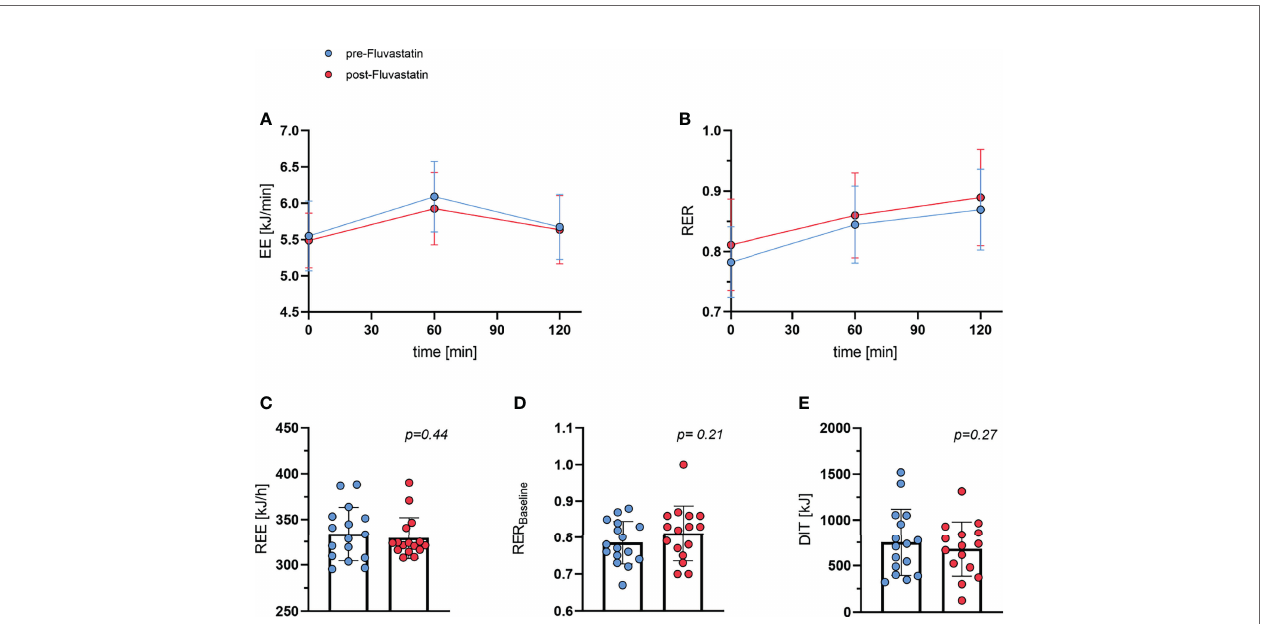
FIGURE 4 | Whole body energy expenditure and respiratory exchange ratio. (A) Energy expenditure (EE) during oGTT. Effect of time after ingestion of glucose p < 0.0001, effect of fl uvastatin p = 0.57, interaction between time x fl uvastatin p = 0.21. (B) Respiratory exchange ratio (RER) during oGTT. Effect of time after ingestion of glucose p < 0.0001, effect of fl uvastatin p = 0.28, interaction between time x fl uvastatin p = 0.56. (C) Resting energy expenditure (REE) before and after two weeks of fl uvastatin p = 0.44. (D) Baseline (0 min of oGTT) respiratory exchange ratio before and after fl uvastatin p = 0.21. (E) Diet induced thermogenesis (DIT), i.e. difference between energy expenditure at baseline vs . 60 min after consuming 75g of glucose p =